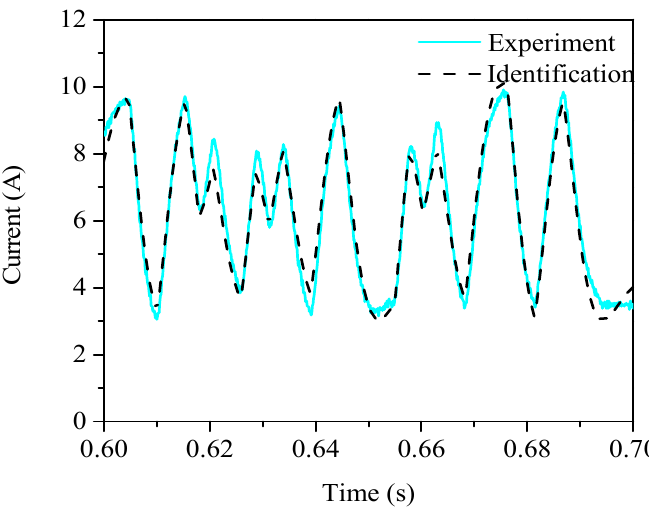
Figure 7. Comparison of the experimental and identification results at sampling rate of 800 Hz.